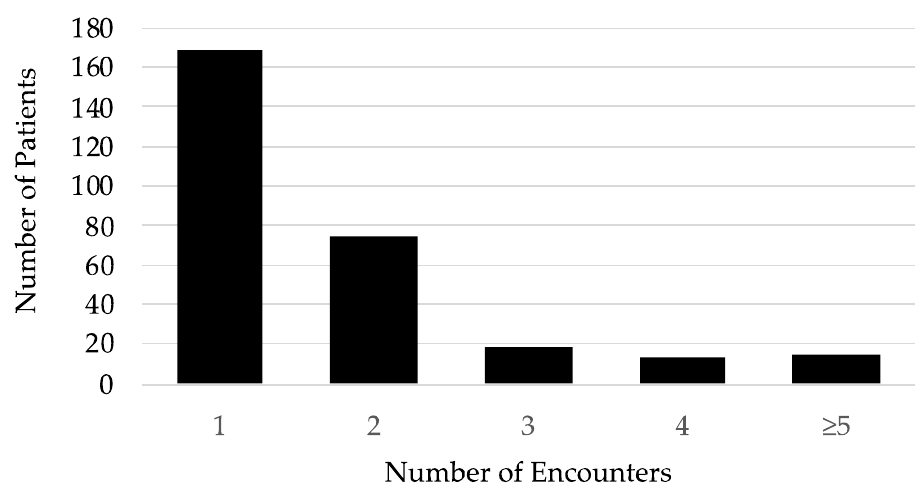
Figure 2. Histogram of urgent care clinic encounters per patient.